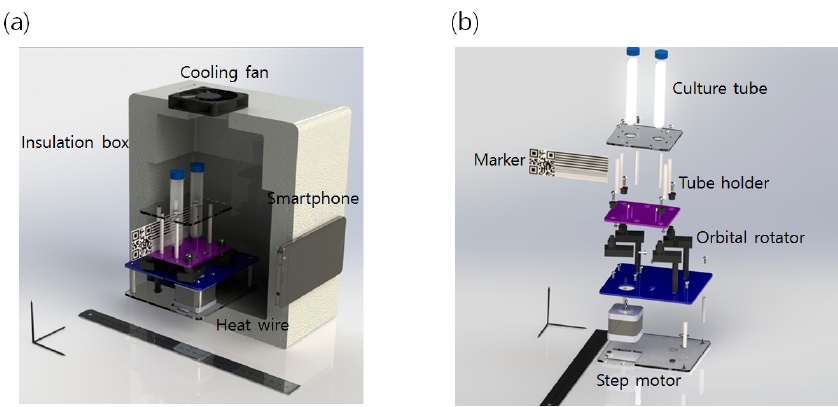
Figure 1. 3D rendering image of the developed automated shaking incubator. ( a ) Cross-sectional diagram and ( b ) exploded diagram. The ruler was added for scale comparison.